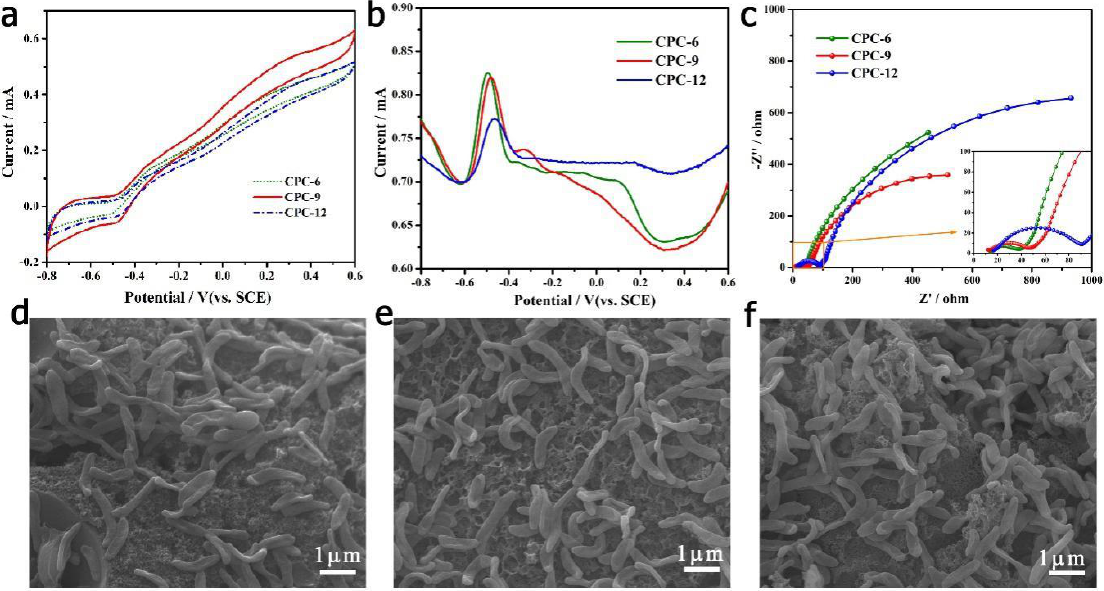
Figure 5. CVs ( a , scan rate 1 mV s −1 ), DPV ( b ) Nyquist plots ( c ) and morphologies ( d , CPC-6; e, CPC-9; f, CPC-12) of different CPC anodes in the S. putrefaciens CN32 half-cell.